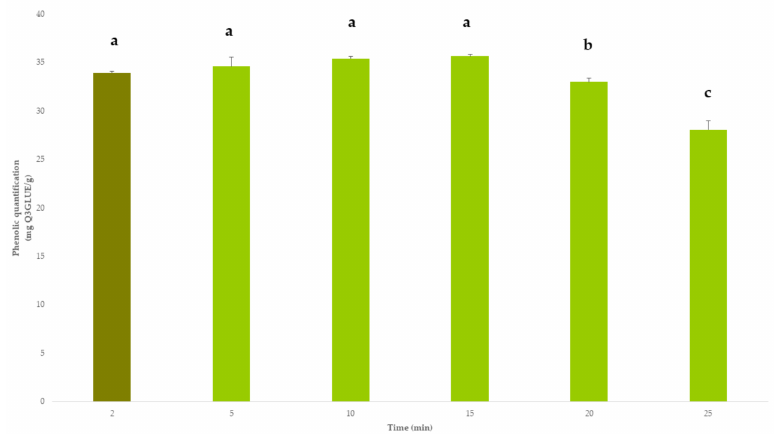
Figure 6. Single-factor study to determine the optimal extraction time. Different letters “a–c” indicate significant differences between results at the 95% confidence level according to Tukey’s test.